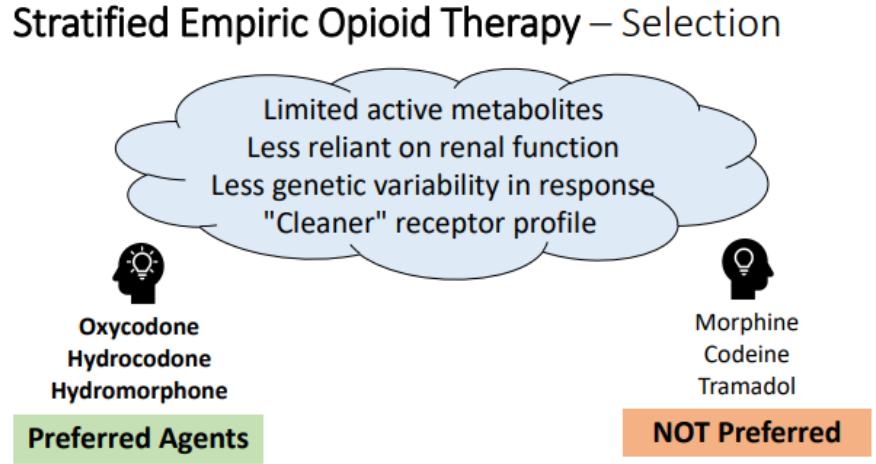
Figure 2. Framework and recommendations for empiric opioid selection. Legend: Key determinants of “ideal” empiric opioids are represented in the thought cloud at top, with specific preferred agents listed at left and non-preferred agents listed at right, based on these qualities. Note- this framework only applies to empiric decision-making in the setting of no prior opioid exposure; these considerations must be melded with patient-specific information and exposure history where applicable.